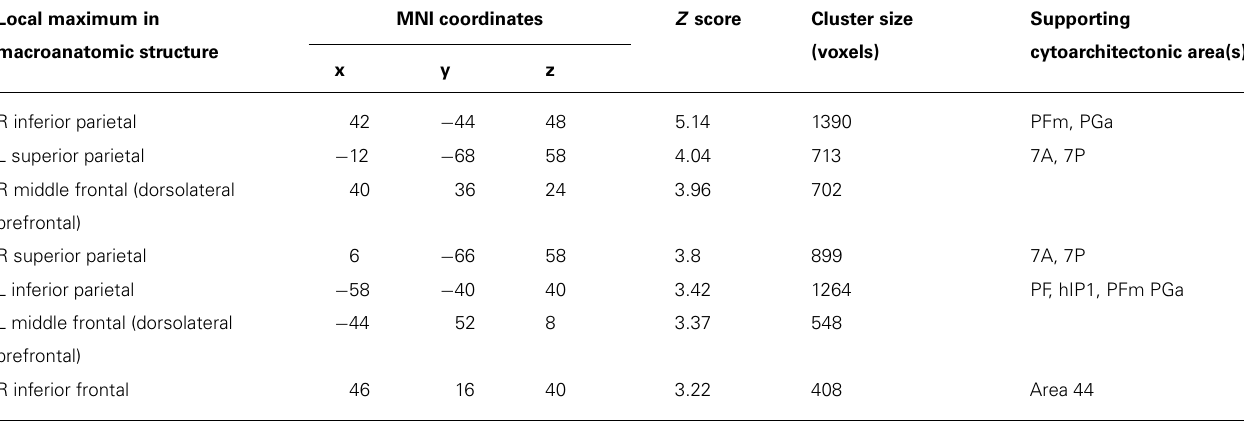
Table 1 |Anatomic locations of activation of quantifier conditions relative to precise number baseline. Local maximum in